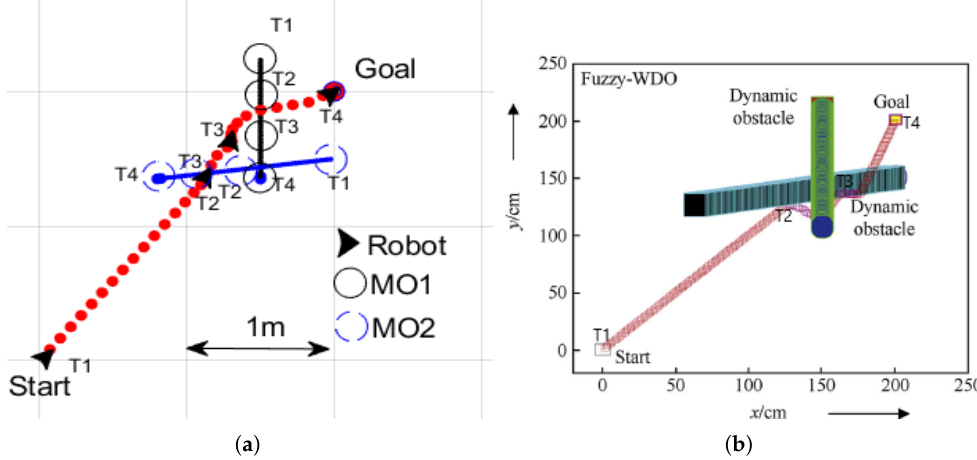
Figure 13. The ANADE and FWDOA. The robot’s and obstacles’ locations at four different time instants, T1–T4. ( a ) The robot’s path with the ANADE. ( b ) The robot’s path with the FWDOA [12].